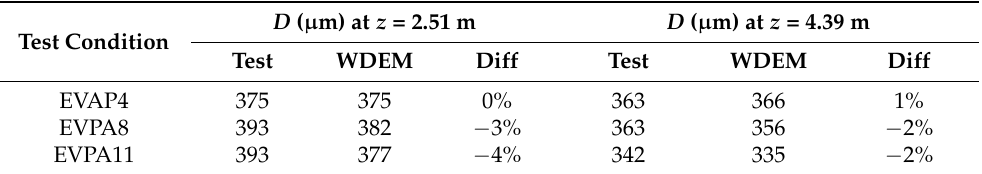
Table 2. Comparison between the evaporation model predictions and CARAIDAS test results [52] for the evolution of droplets